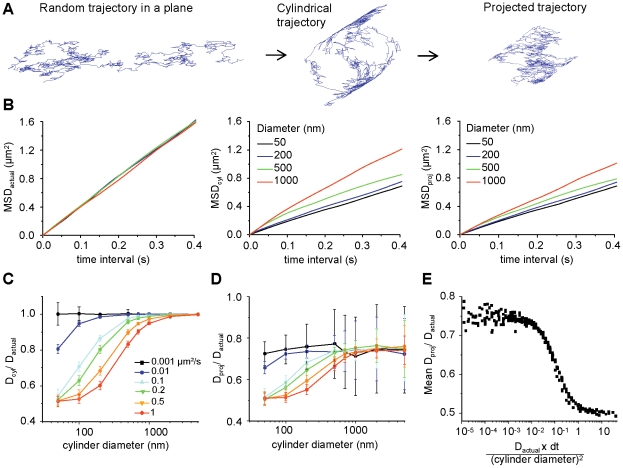
of geometry on diffusion measurements on cylindrical structures.
A) Example of a random trajectory simulated on a plane and the derived cylindrical and projected trajectories. B) Examples of MSD plots of the original trajectories (MSDactual, left), the trajectories on cylindrical surfaces (MSDcyl, centre) or projected (MSDproj, right) ones, for cylinders of the indicated diameters. Trajectories were simulated with a diffusivity of 1 µm2/s. C–D) Ratios of D calculated on trajectories on cylindrical surfaces (C, Dcyl) or projected (D, Dproj) trajectories to the real diffusion constant of the original trajectory in the plane (Dactual), as a function of the diameter of the cylinder. Each curve represents the mean ± SD values for 50 trajectories simulated to have the indicated diffusivities (0.001 to 1 µm2/s). E) The mean ratio Dproj / Dactual as a function of the dimensionless parameter () incorporating the diffusion coefficient (Dactual), the image acquisition interval (dt) and the cylinder diameter (Ø).